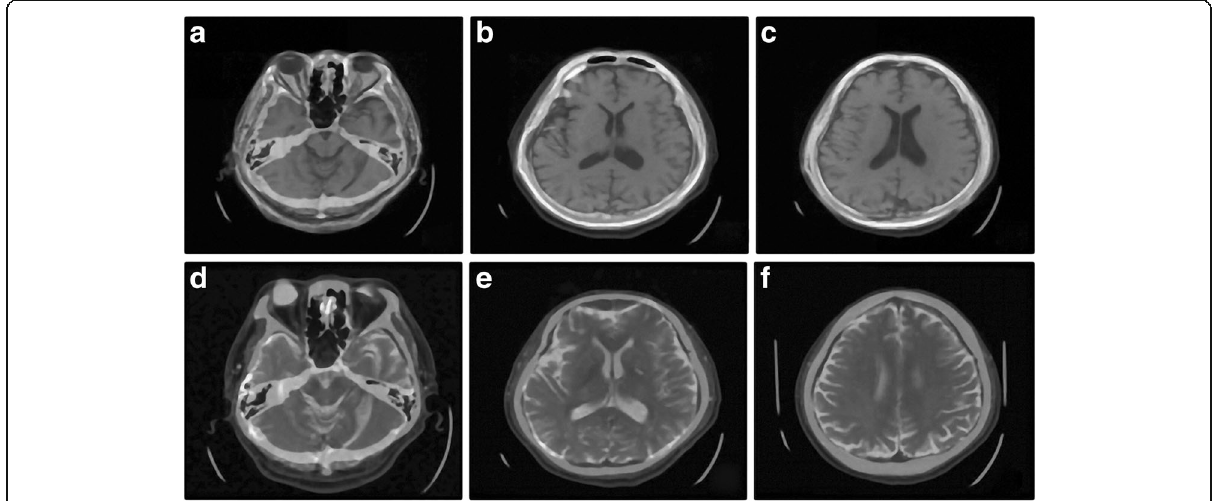
Fig. 16 The wavelet-weighted fusion result of patient two. a , b , c are the fusion results of CT and T1-MRI, while d , e , f are the fusion result of CT and DWI